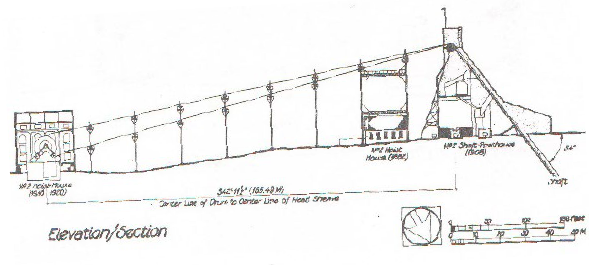
Figure 8. General view of the Quincy Mine, 1882-1920 (Quincy Mining Company HAER, 2019)